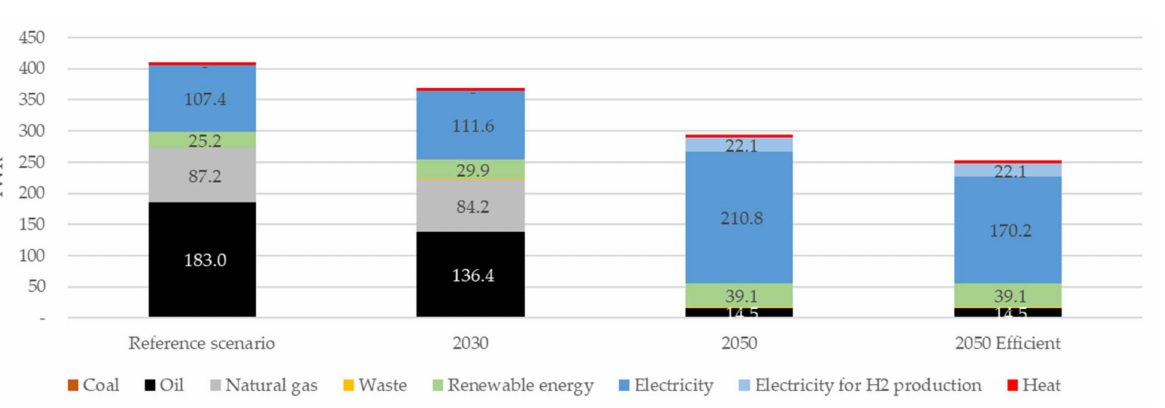
Figure 4. Bioregion final energy consumption in